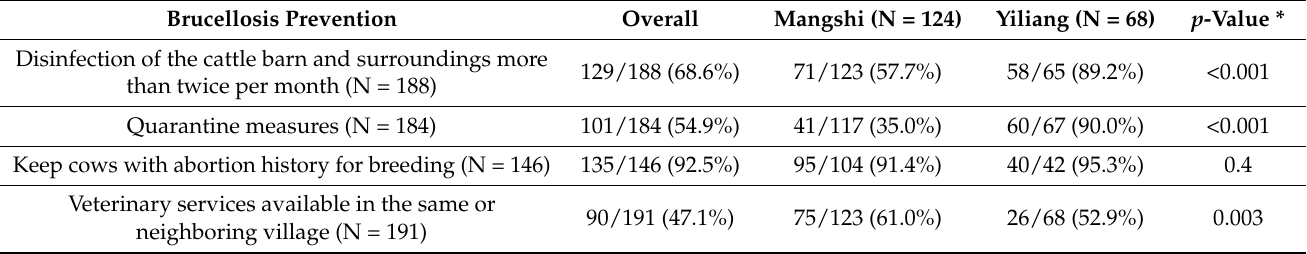
Table 3. Management factors and access to vet service in two counties in Yunnan province, China. Data from questionnaire. Brucellosis Prevention Overall Mangshi (N = 124) p -Value * Disinfection of the cattle barn and surroundings more than twice per month (N = 188) Quarantine measures (N =